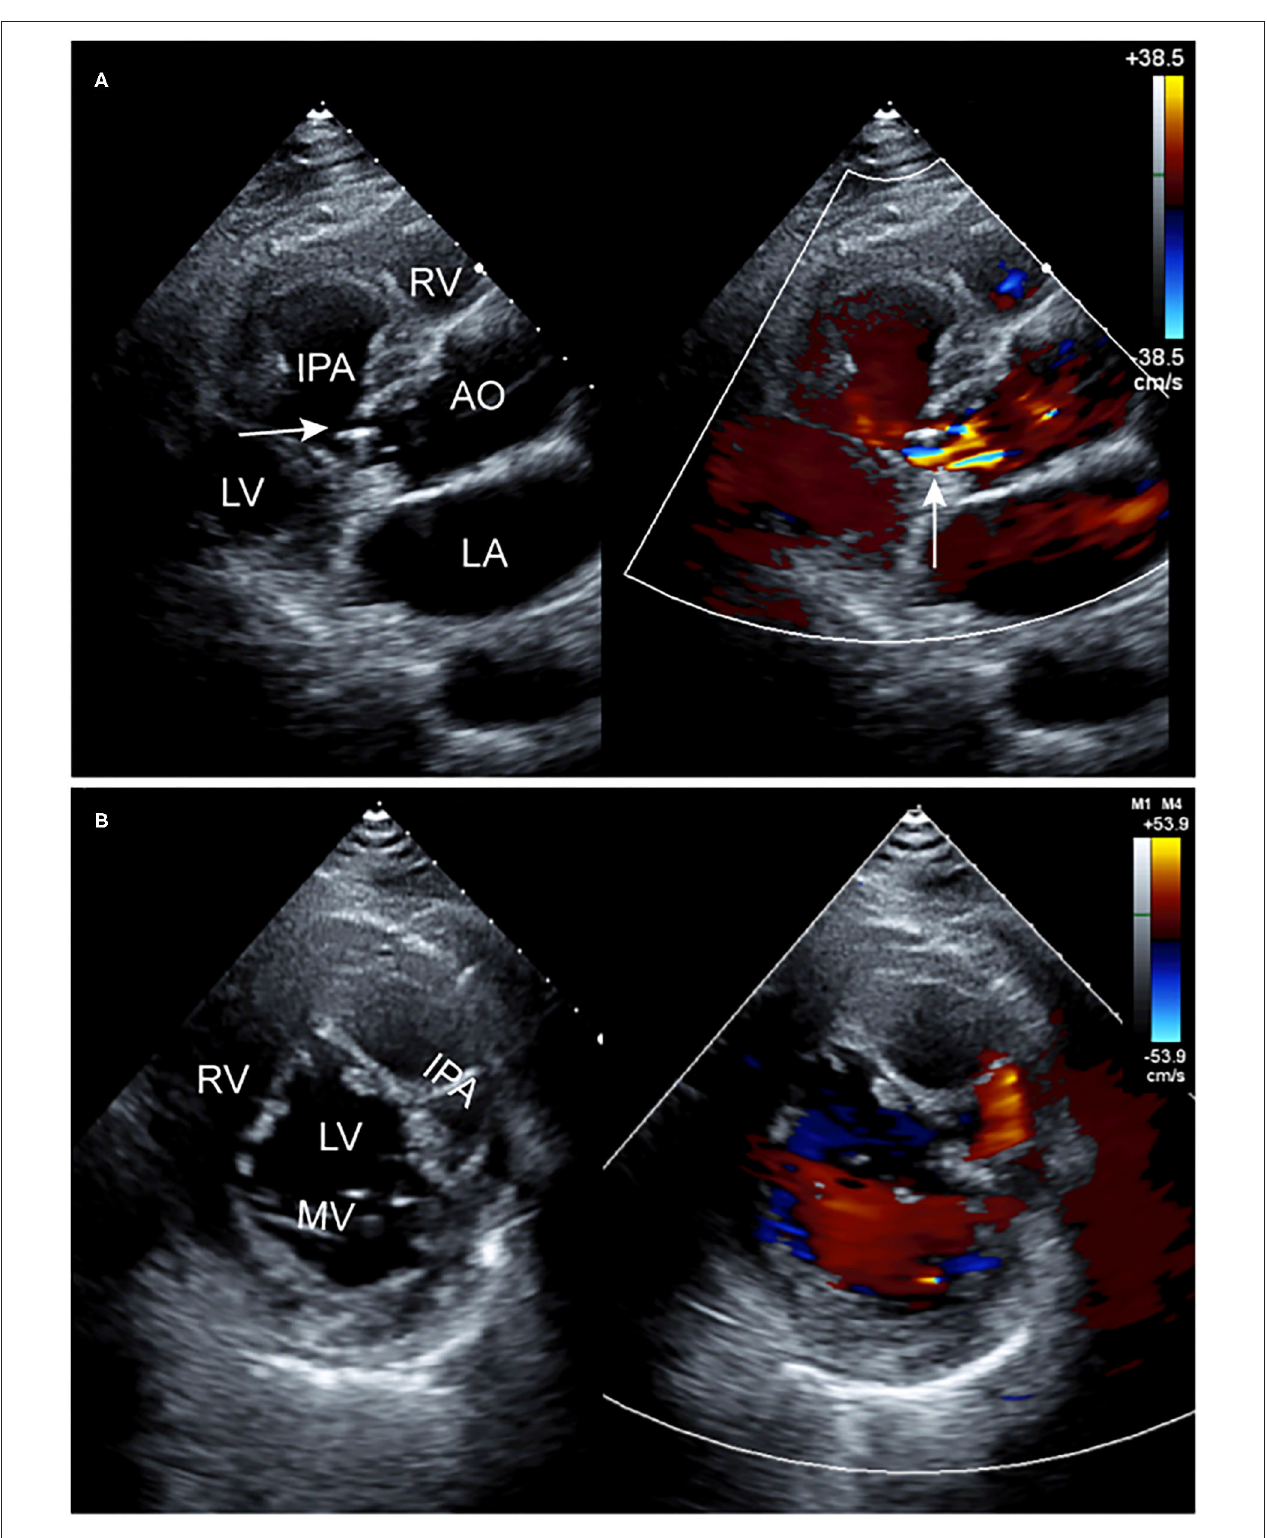
FIGURE 1 | Two-dimensional transthoracic echocardiographic images. (A) Long-axis view of the left ventricle showing an echo-lucent cavity in the left-ventricular myocardium with abnormal blood flow on color Doppler (arrow). (B) Short-axis view at the MV (mitral valve) level also showing the echo-lucent cavity with partitions in the left-ventricular myocardium and abnormal blood flow on color Doppler. AO, aorta; LA, left atrium; LV, left ventricle; RA, right atrium; RV, right ventricle; RVOT, right ventricular outflow tract.